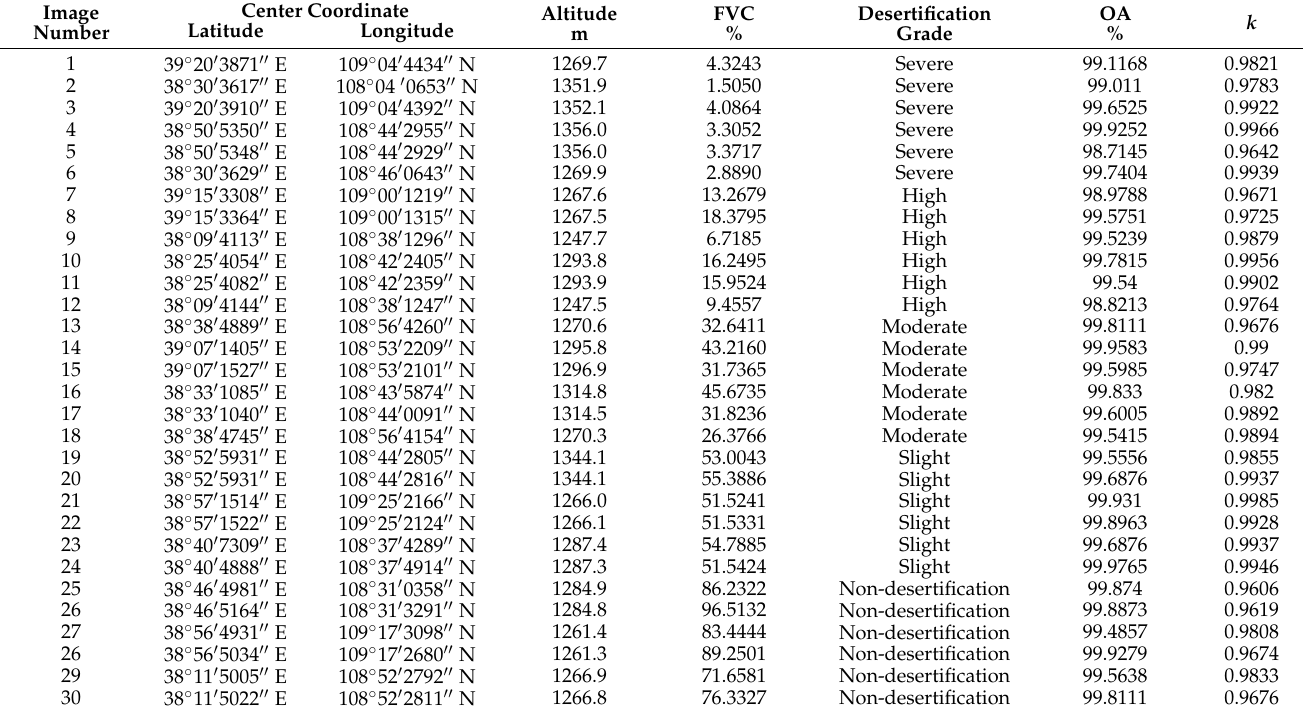
Table 3. Supervised classification results of 30